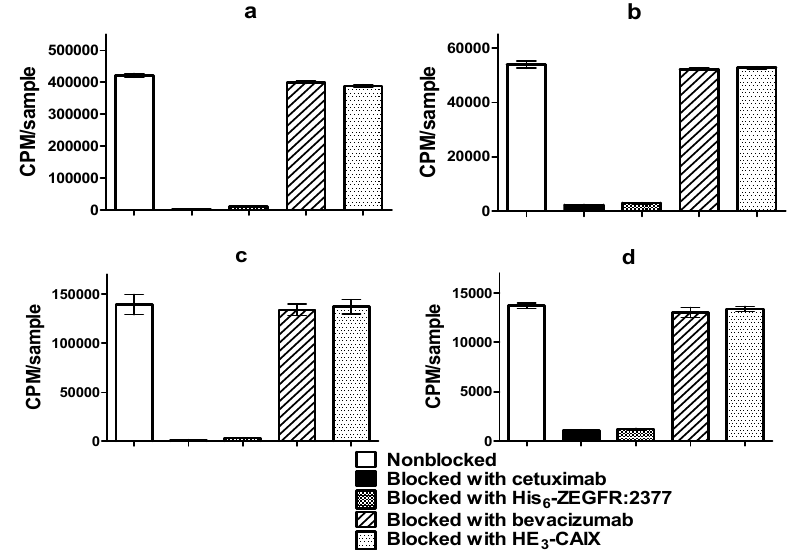
Figure 4. In vitro specificity of [ 68 Ga]Ga ‐ DFO ‐ ZEGFR:2377 conjugate labeled at RT bound to ( a ) A431 and ( b ) PC3; labeled at 85 °C bound to ( c ) A431 and ( d ) PC3. Cells were incubated with 5 nM [ 68 Ga]Ga ‐